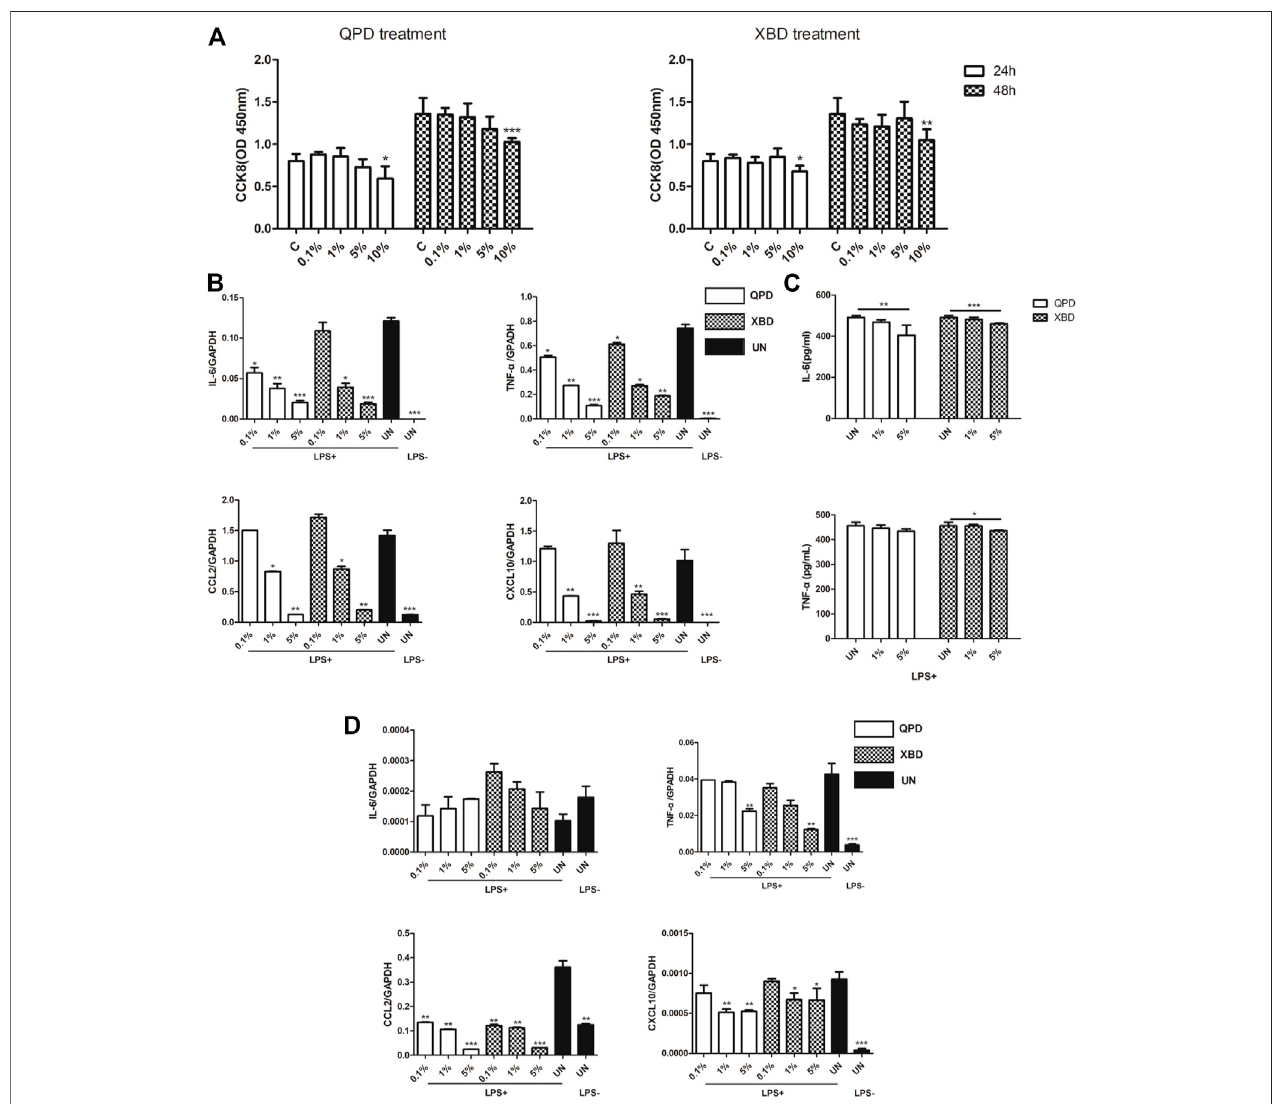
FIGURE 3 | QPD and XBD inhibited in fl ammatory cytokines expression in LPS-stimulated THP-1 macrophages. Cytotoxic effect of QPD (left) and XBD (right) on THP-1macrophages (A) .THP-1monocyteswereseededat0.5 × 10 6 /ml,2 mlperwellin6-wellplatesanddifferentiatedintoM0macrophagesbeforeQPDorXBDwas added into each well at indicated concentrations (%, v/v). 24 h post QPD or XBD treatment, the supernatant was removed and the cells were washed with PBS three times and incubated in the medium supplied with or without 1 µg/ml LPS and 20 ng/ml IFN- γ . 6 h later, the total RNA was extracted to detect IL-6, TNF- α , CCL2, andCXCL10mRNAlevelsbyRT-qPCR (B) .24 hlater,thesupernatantwascollectedtoanalyzeIL-6andTNF- α byELISA (C) .M0THP-1macrophagesweretreatedwith orwithout1 µg/mlLPSand20 ng/mlIFN- γ for6 hand thentreatedwithQPDorXBDat indicatedconcentrationsfor24 h.TotalRNAwasextracted todetectIL-6,TNF- α , CCL2, and CXCL10 mRNA levels by RT-qPCR (D) . C and UN, untreated control. LPS+, treated with LPS and IFN- γ ; LPS-, treated without LPS and IFN- γ . Data are presented as mean ± SD ( n ≥ 3). * p < 0 . 005; ** p < 0 . 001; *** p < 0 . 001 compared with C or UN + LPS group or as